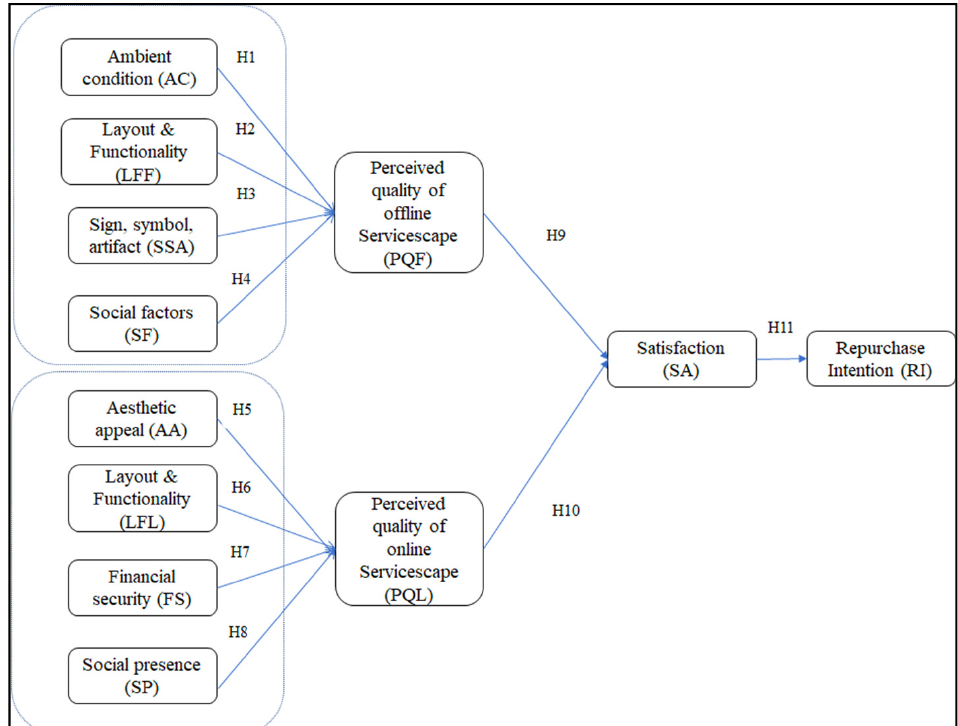
Figure 1. Research Theoretical Framework.